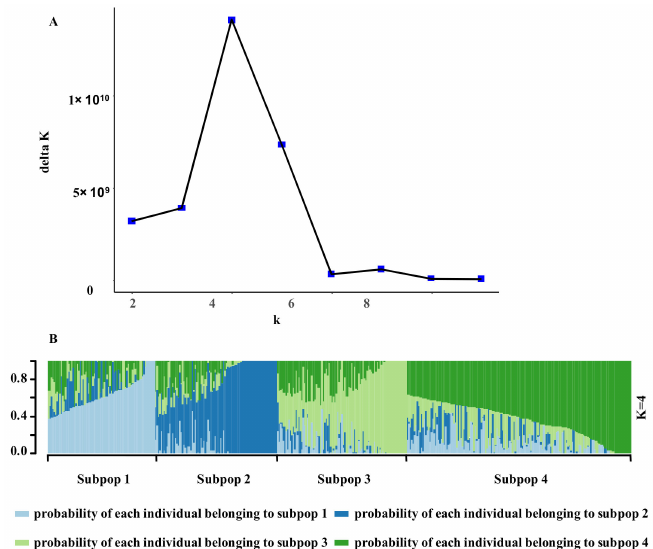
Figure 1. Population genetic analysis of 410 faba bean accessions: ( A ) the K-value changing with ∆ K indicates that the 410 faba bean accessions can be divided into four subpopulations; ( B ) the population structure of the 410 faba bean